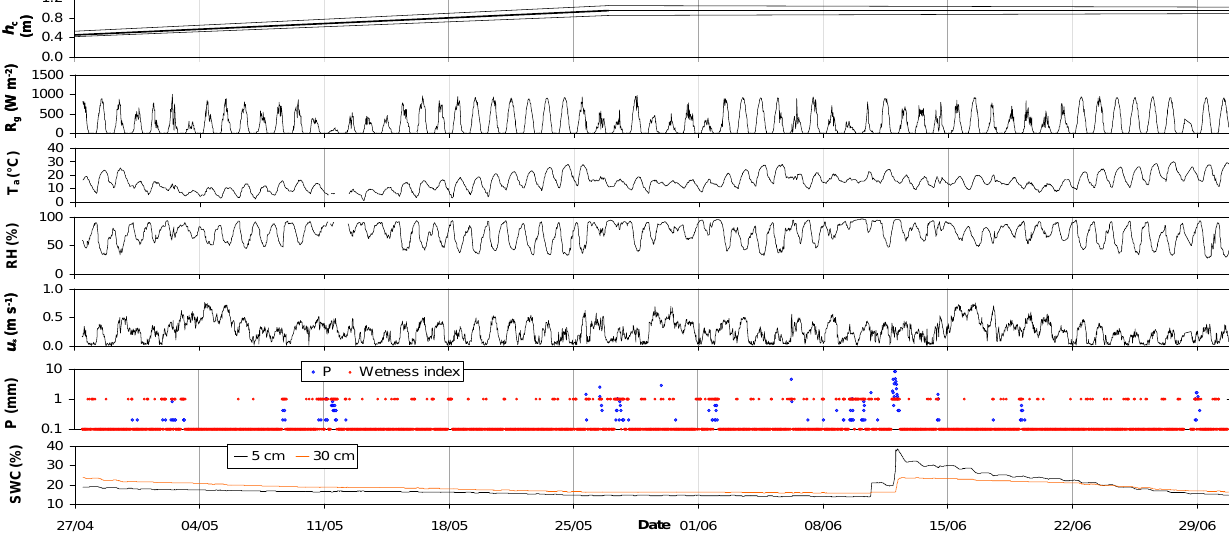
Figure 4. Canopy height (h c ) and micrometeorological conditions measured at the site. From top to bottom: canopy height (h c ), global radiation ( R g ), air temperature ( T a ) and relative humidity at 2 m above the ground, friction velocity ( u * ), precipitation (P, left axis), wetness index (right axis), and soil water content (SWC) at 5 and 30 cm depth. For the canopy height, the mean, minimum and maximum heights are shown.